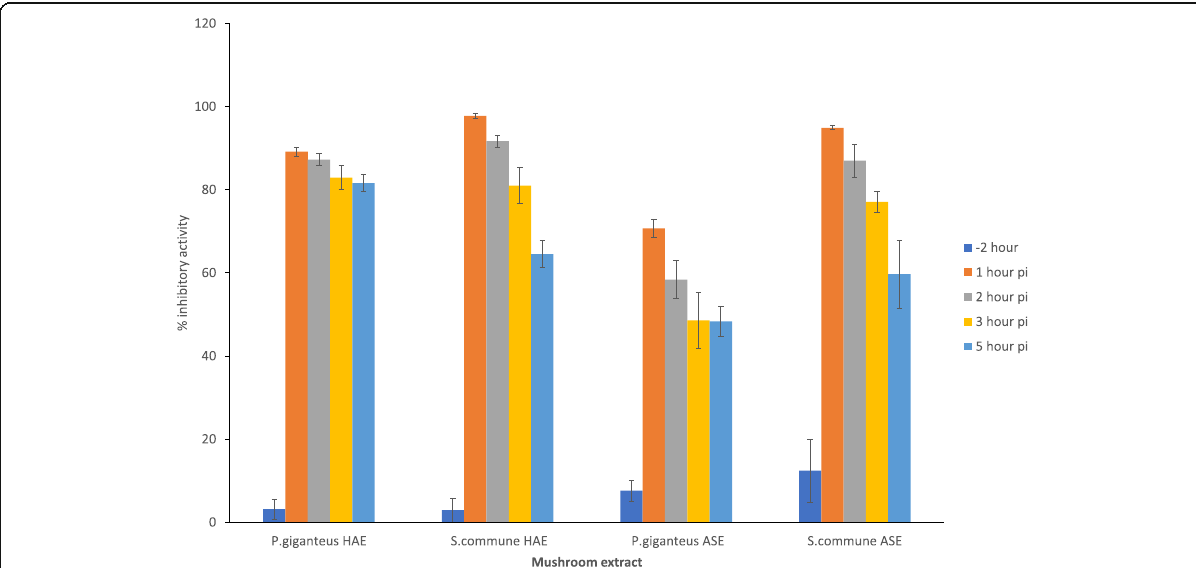
Fig. 2 Time of addition effect of active mushroom extracts on dengue virus replication in vero cells by the plaque reduction assay. Overlay containing 2000 μ g/ml of mushroom extracts were added to the Vero cell monolayer either 2 h before viral adsorption or 1, 2, 3 or 5 h after viral adsorption (80-100PFU). Percentage of inhibitory activity of extracts was determined by plaque reduction assay. Data are expressed as mean ± standard deviation of three independent experiment ( n =